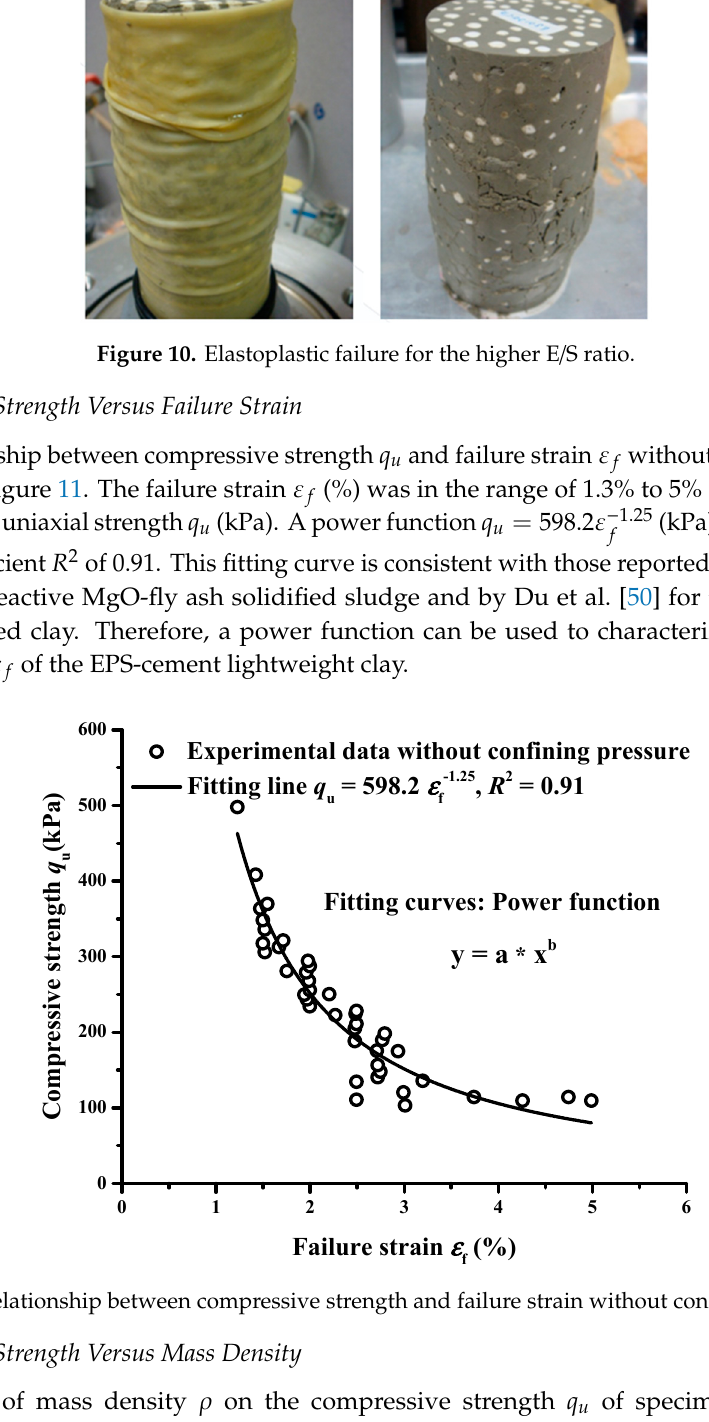
Figure 9. Shear failure for the lower E/S ratio.